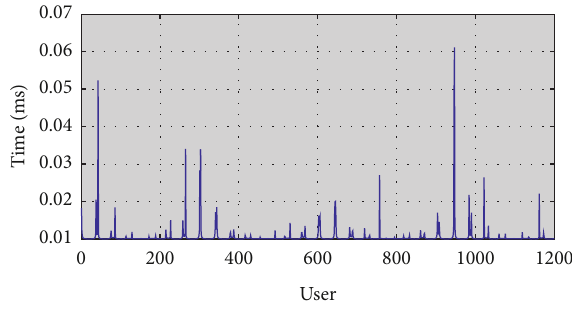
Figure 10: Scoring database user’s